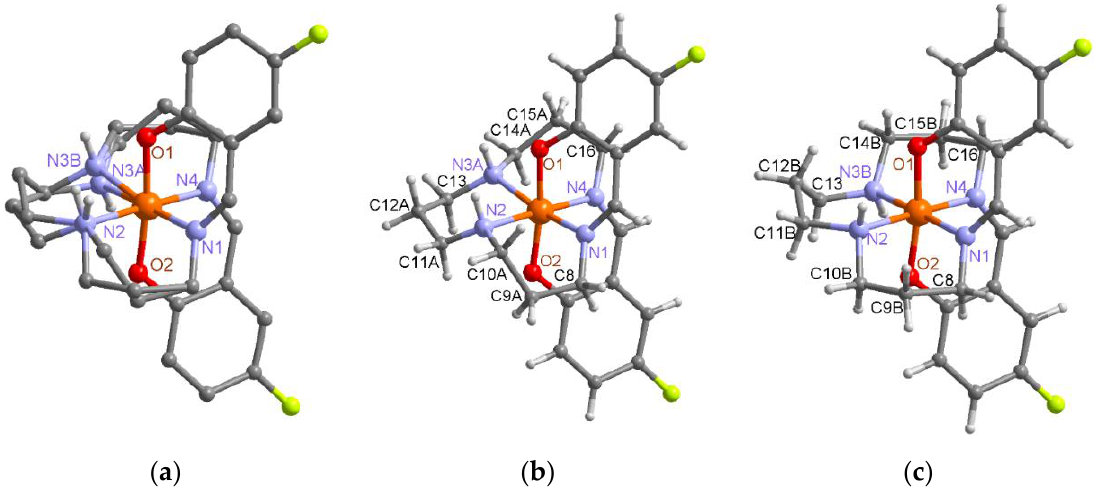
Figure 5. View of asymmetric unit of [Fe(5F-sal 2 333)]BPh 4 , 2 , showing ( a ) disorder of three propylene groups in ligand backbone due to co-crystallization of meso and non- meso forms; view of ( b ) the meso form and ( c ) the pure non- meso orientation. Table 2. Bond length data for complexes 1 and 2